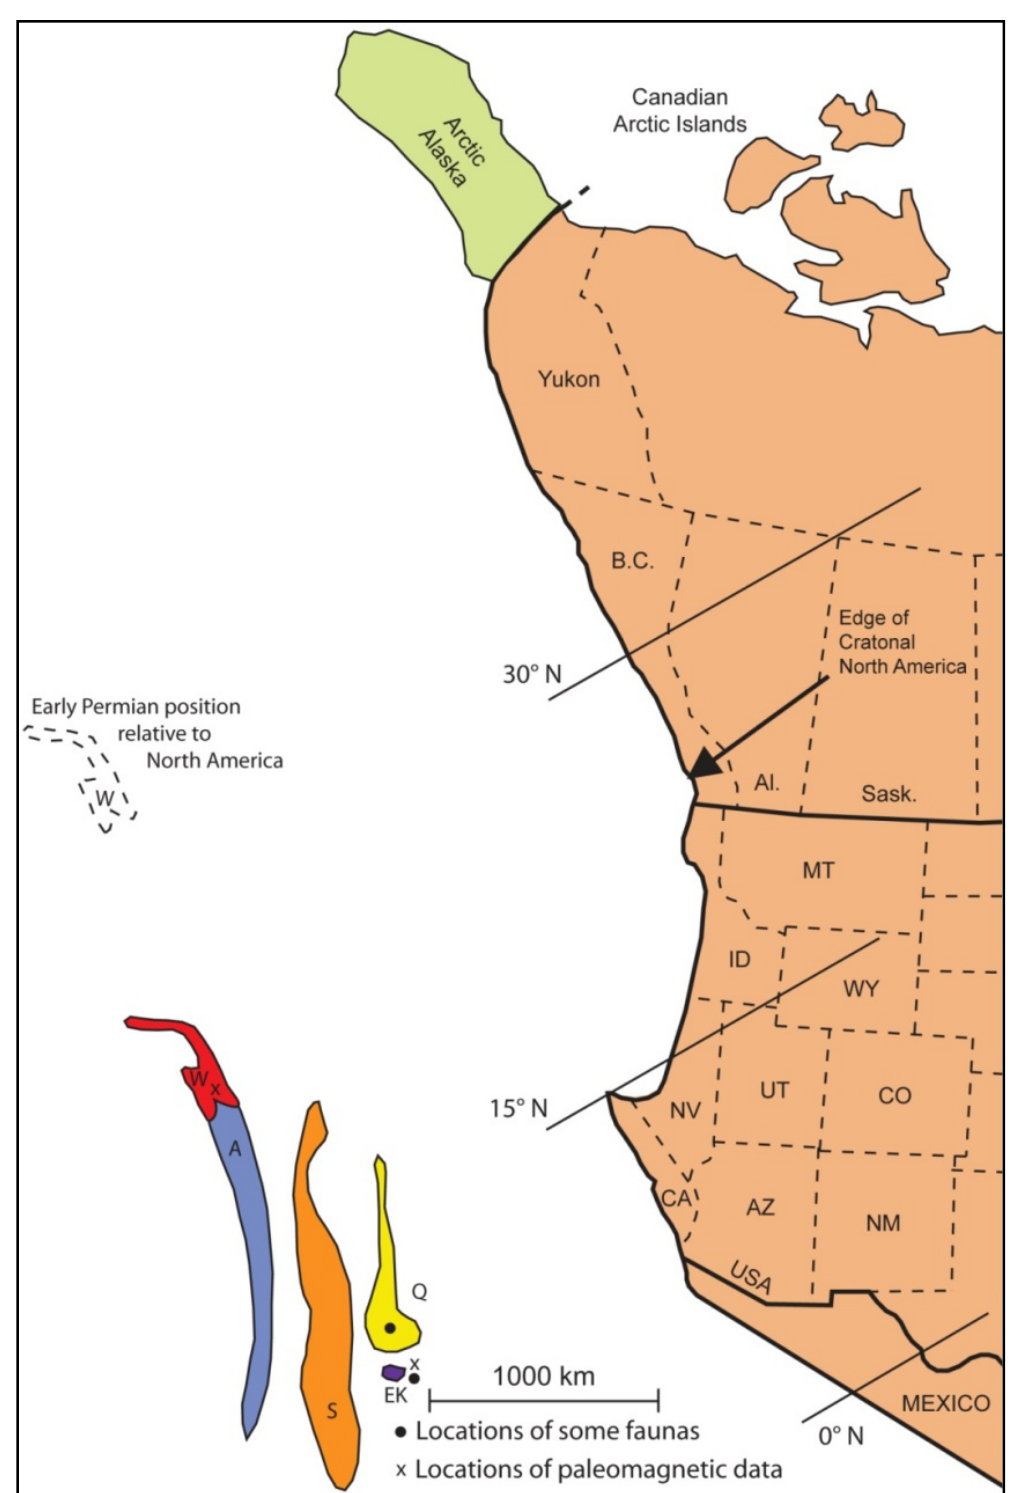
Figure 5. Interpreted Middle Permian position of allochthonous terranes. For abbreviations see caption for Figure 3. Paleolatitudes for cratonal North America are from Scotese and McKerrow